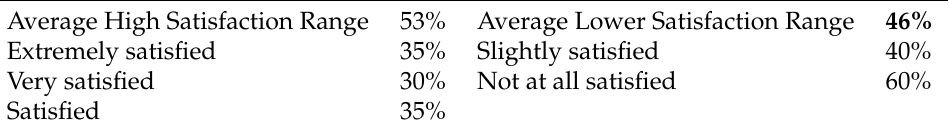
Table 17. Satisfaction Levels for regular fitting design patterns (before